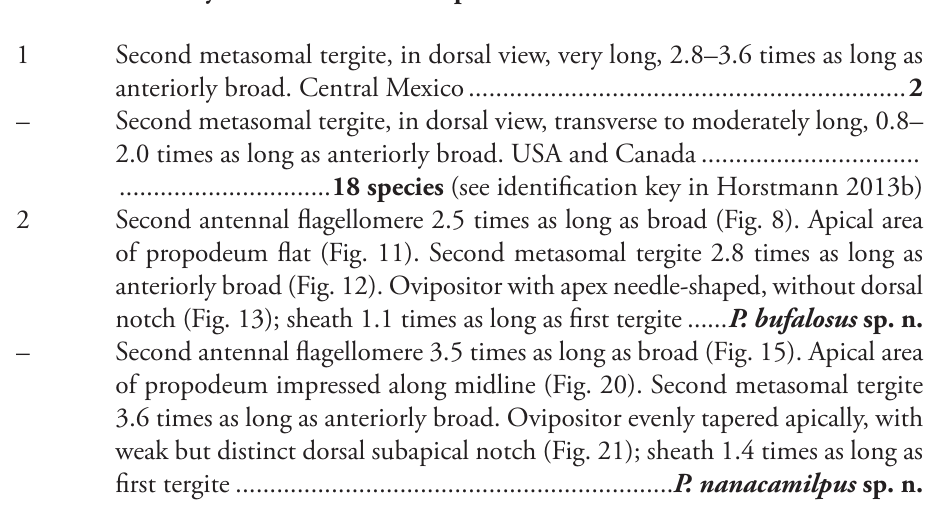
Comparison. In the key to the Nearctic species of Phradis (Horstmann 2013b), P. bu- falosus runs to P. flavicoxa Horstmann in couplet 9 but may be distinguished from this species by the head being weakly constricted behind the eyes (Fig. 9), dark legs (Fig. 10), smooth first metasomal tergite, long second tergite (Fig. 12) and a needle- shaped ovipositor apex (Fig.